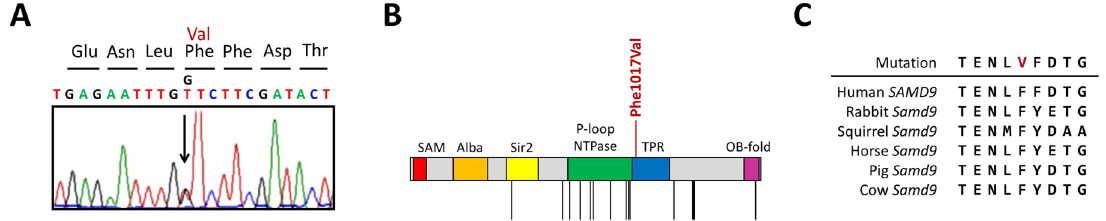
Fig 2. Identification of a novel SAMD9 variant, p.Phe1017Val. A, A partial electropherogram of the PCR product. The patient had a nucleotide substitution of thymine for guanine in the 1017th codon (indicated by an arrow). B, A schematic diagram of the SAMD9 protein with domain features. Positions of previously described MIRAGE syndrome-associated variants are indicated by black lines. The p.Phe1017Val variants was located in the TPR repeats. The domain architecture was based on Mekhedov et al ., Biol Direct . 2017;12:13. C, Single-letter amino acid Clustal alignments of the residues surrounding the Phe 1017 . The mutated residue is evolutionarily conserved.